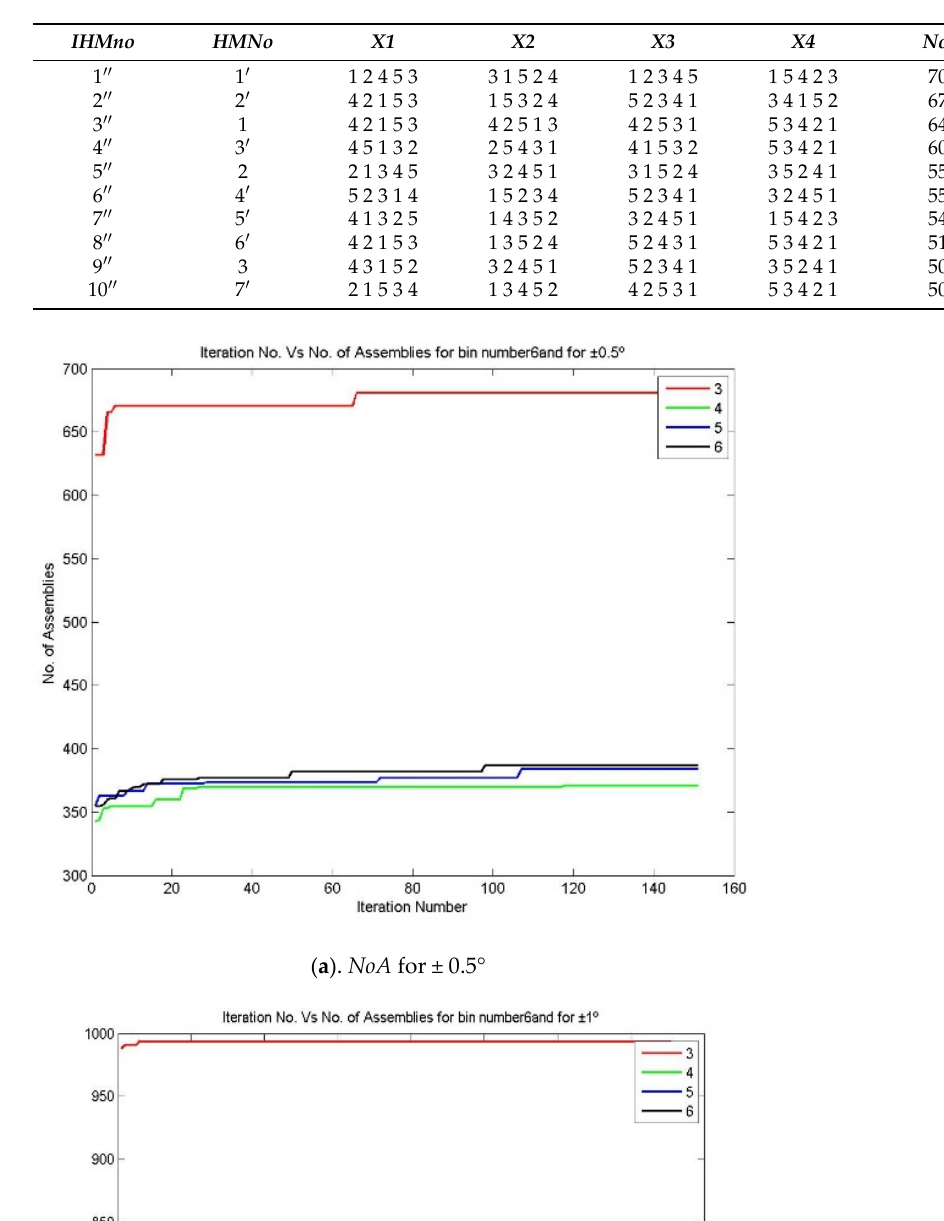
Table 14. Selected harmonies for next iteration.